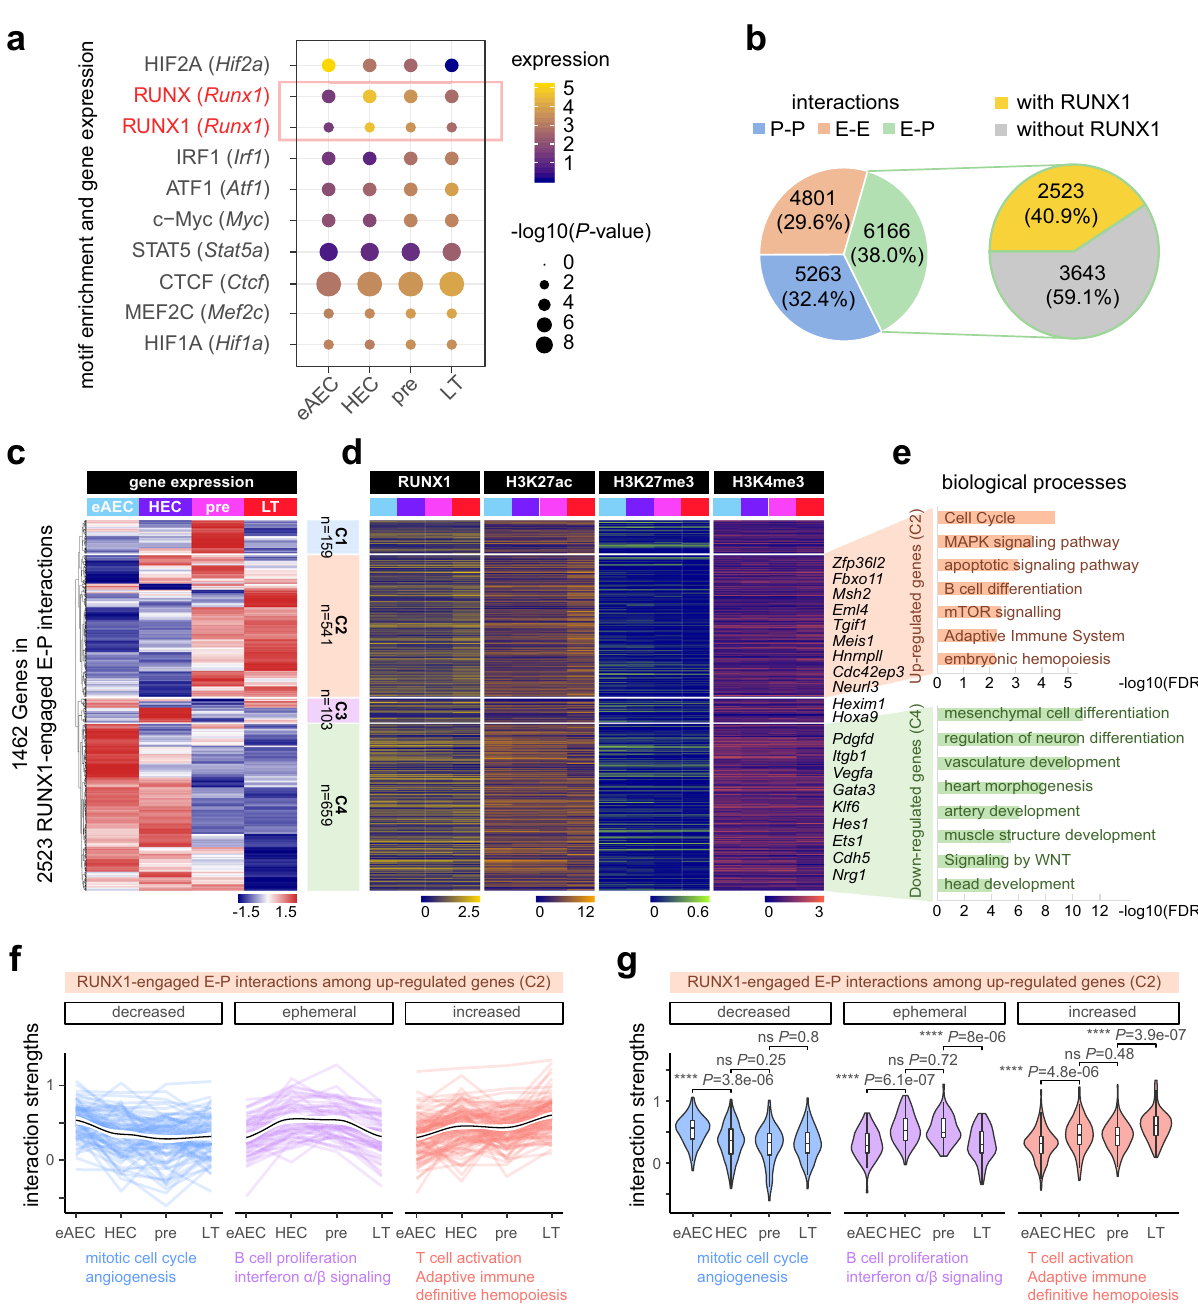
Fig. 4 RUNX1 is engaged in looping between promoters and enhancers for priming genome interactions during HSC formation. a Bubble plots showing gene expression and TF motif enrichment, identi fi ed at anchor regions of C3 loop clusters as in Fig. 3a, with most variable gene expression. TF motif analysis was performed by HOMER. P -value was calculated by two-sided binomial test. b Pie chart showing the portion of E – E, P – P, and E – P interactions with or without RUNX1 occupancy. c Heatmap showing hierarchical clustering based on the expression of genes with RUNX1-engaged E – P interactions. d Heatmap showing the corresponding RUNX1 binding and histone modi fi cations on looping sites as in ( b ). Representative genes were listed on the right. The ANOVA P -values (one-sided) of TF or histone modi fi cation signals in C2 hematopoietic cluster were 1.27e − 05 **** for RUNX1, 3.92e – 12 **** for H3K27ac, 0.000216 *** for H3K27me3, and 0.0606ns for H3K4me3. e Gene Ontology analysis of biological processes supporting the clustering. f Lines re fl ecting strengths of three sub-clusters of RUNX1-engaged E – P interactions among C2 genes. Those RUNX1-engaged E – P interactions existing from eAEC to LT-HSC were used for clustering. Smoothly fi tted interactions dynamics into a function (method = ‘ loess ’ ) in each cluster, the black line indicates the predicted value. The thick white bars represented a 95% con fi dence interval. g Violin plots quantifying the strengths of three sub-clusters of RUNX1- engaged E – P interactions among C2 genes, corresponding to ( f ). For decreased interactions, n = 91. For ephemeral interactions, n = 60. For increased interactions, n = 113. Box-and-whiskers plots represented the maxima, 75th percentile, median, 25th percentile, and minima. The two-sample Wilcoxon Rank Sum test (two-sided) was performed between two adjacent stages. * P -value < 0.05; ** P -value < 0.01; *** P -value < 0.001; **** P -value < 0.0001; “ ns ” not signi fi cant. eAEC early AEC, pre pre-HSC, LT